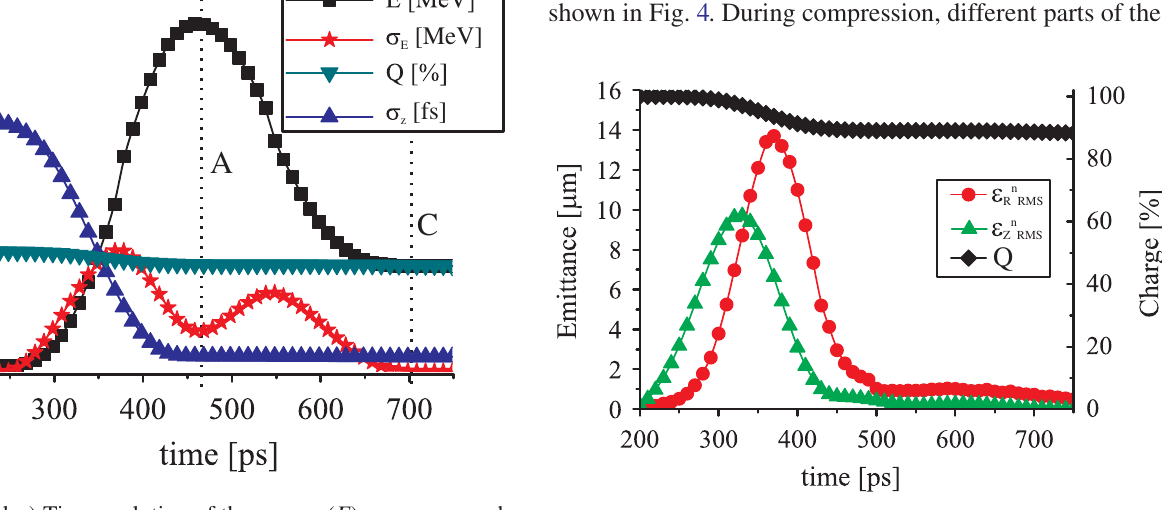
). The first dotted line (A) z